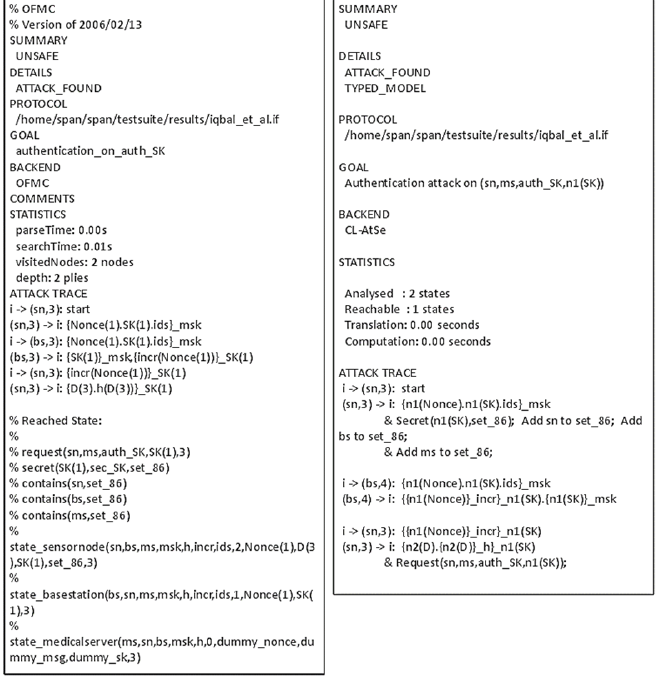
Figure 13. AVISPA result of Iqbal et al.’s protocol.